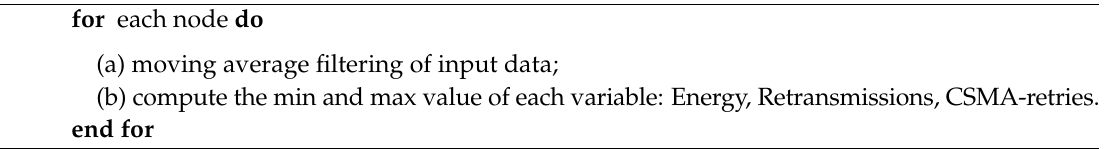
Algorithm 1: Training of the detection algorithm. for each node